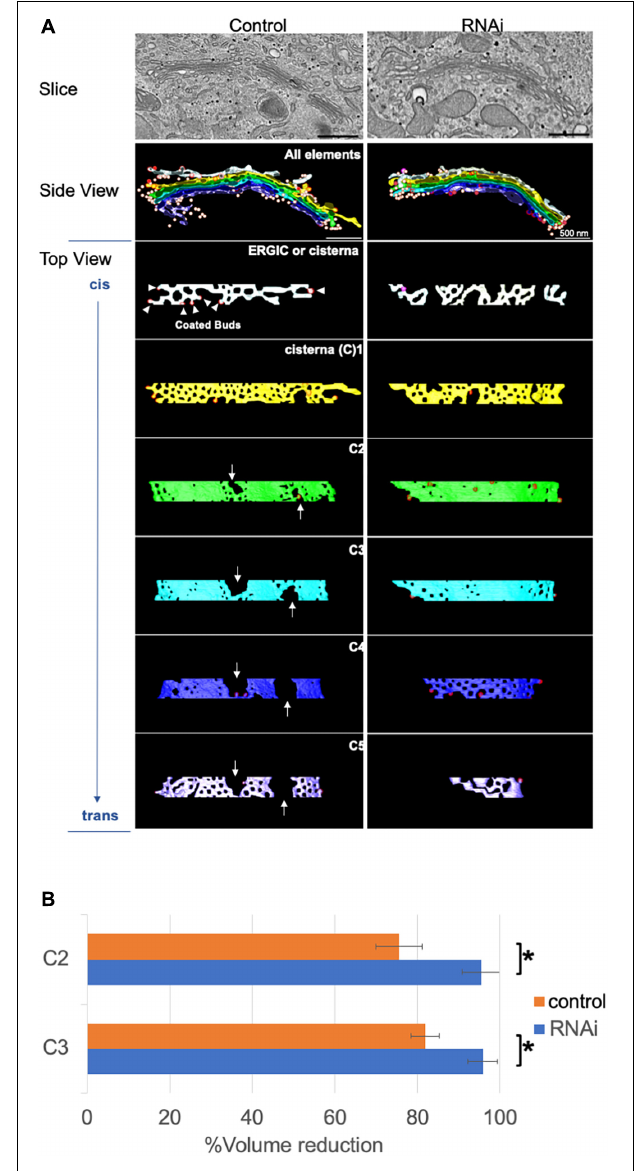
FIGURE 3 | Loss of Giantin fuses Golgi cisternae. (A) Typical 3D models of Golgi cisternae in Giantin and control siRNA-treated cells. One of the tomographic slices used for these 3D models is shown in top panels. Note that the Golgi cisternae visible in RNAi cells appear longer than those in control cells. Bar, 500 nm. Arrows indicate large fenestrae in cisternae. The cis -most and trans -most cisternae are labeled C1 and C5, respectively. (B) The reduction of cisternal volumes from the corresponding no-fenestra model is shown as the % volume reduction in Giantin and control siRNA-treated cells. Bar, SD ( n = 4, ∗ P <